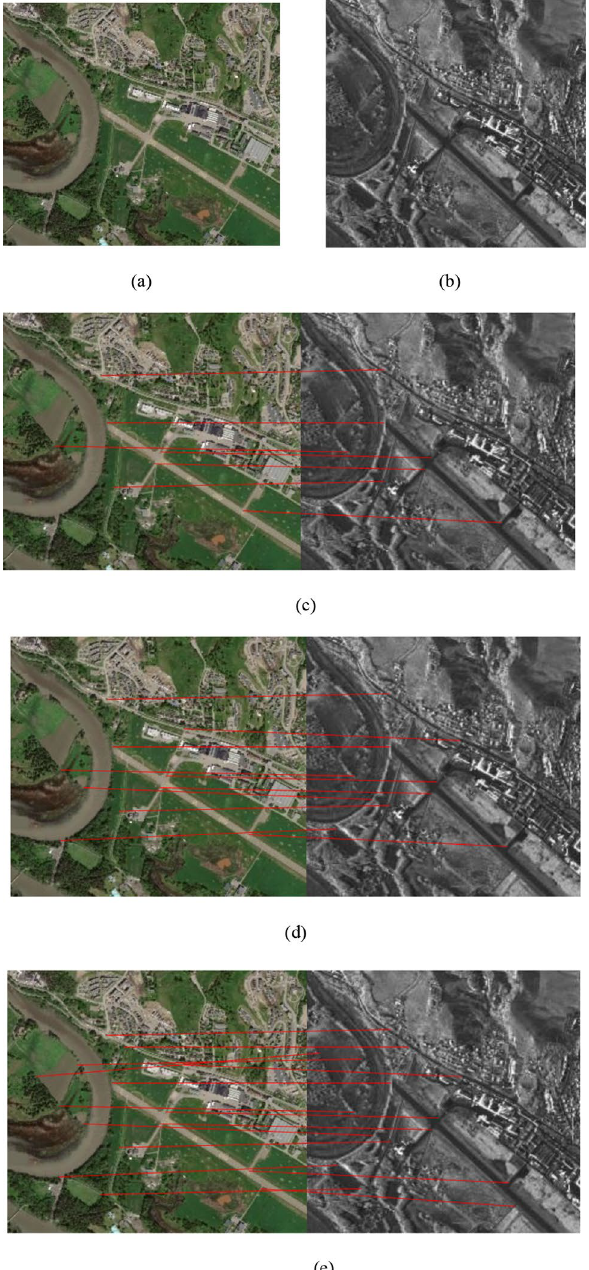
Figure 1. ( a ) Optical image; ( b ) SAR image; Matches found in pair 1 using ( c ) PSO-SIFT, ( d ) OS-SIFT, and ( e ) the proposed method. The reference image is shown on the left and the sensed image on the